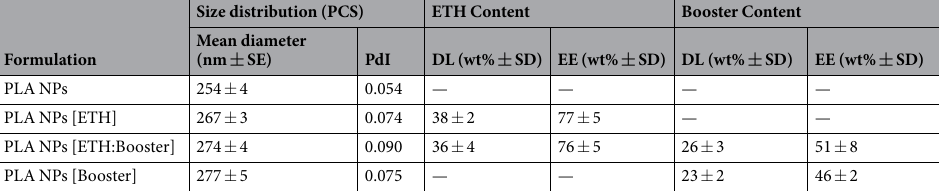
Table 1. Main characteristics of empty and drug-loaded PLA NPs made of P4 by nanoemulsion. NPs mean hydrodynamic diameters were determined by PCS and are reported as Mean diameter (Z average nm ± standard error) and Polydispersity Index (PdI). ETH and Booster drug loading (DL) and encapsulation efficiency (EE) were determined by LC-MS-MS and RP-HPLC (the data are mean values ± standard